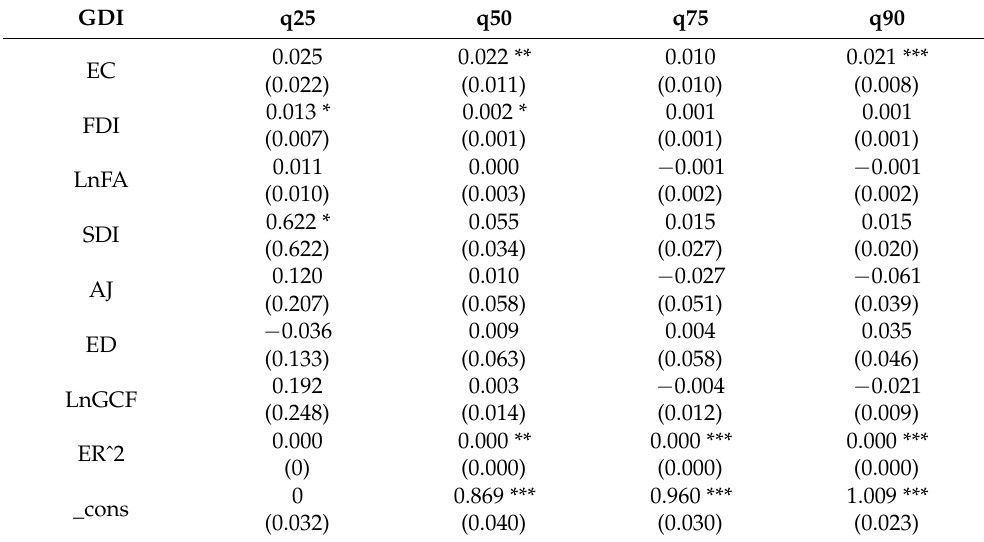
Table 6. Results of Generalised Quantile Regression 2000–2020 (In presence of Higher Enrolment